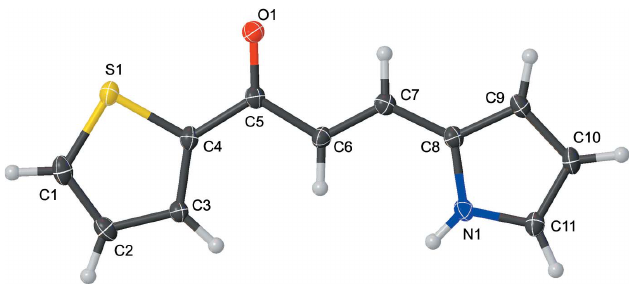
Figure 1 The molecular structure of the title compound, showing the atom labelling. Displacement ellipsoids are drawn at the 50% probability